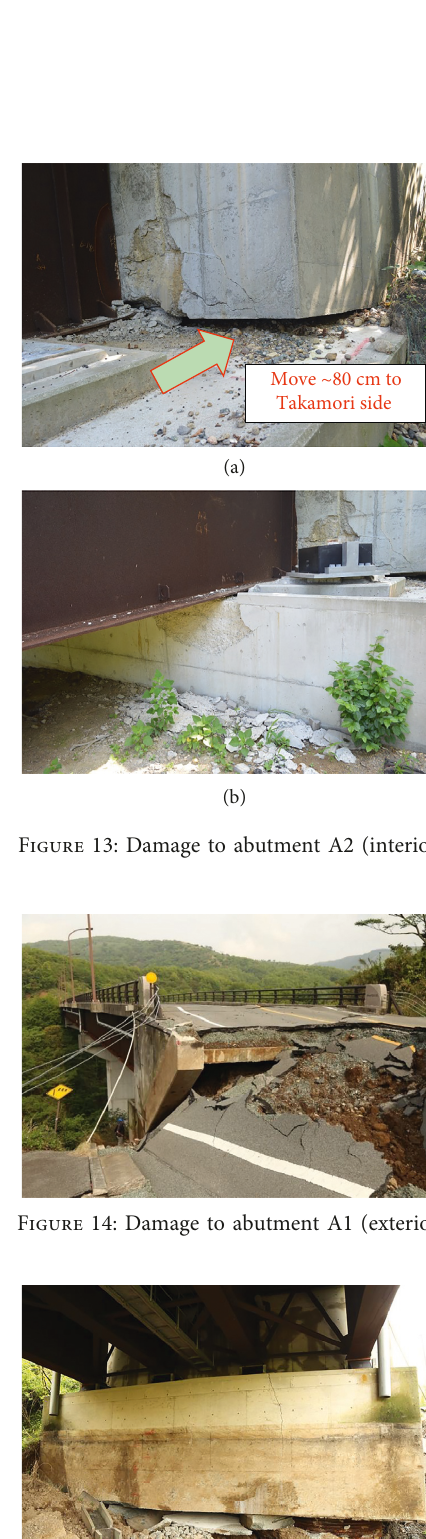
Figure 17: Damage to the